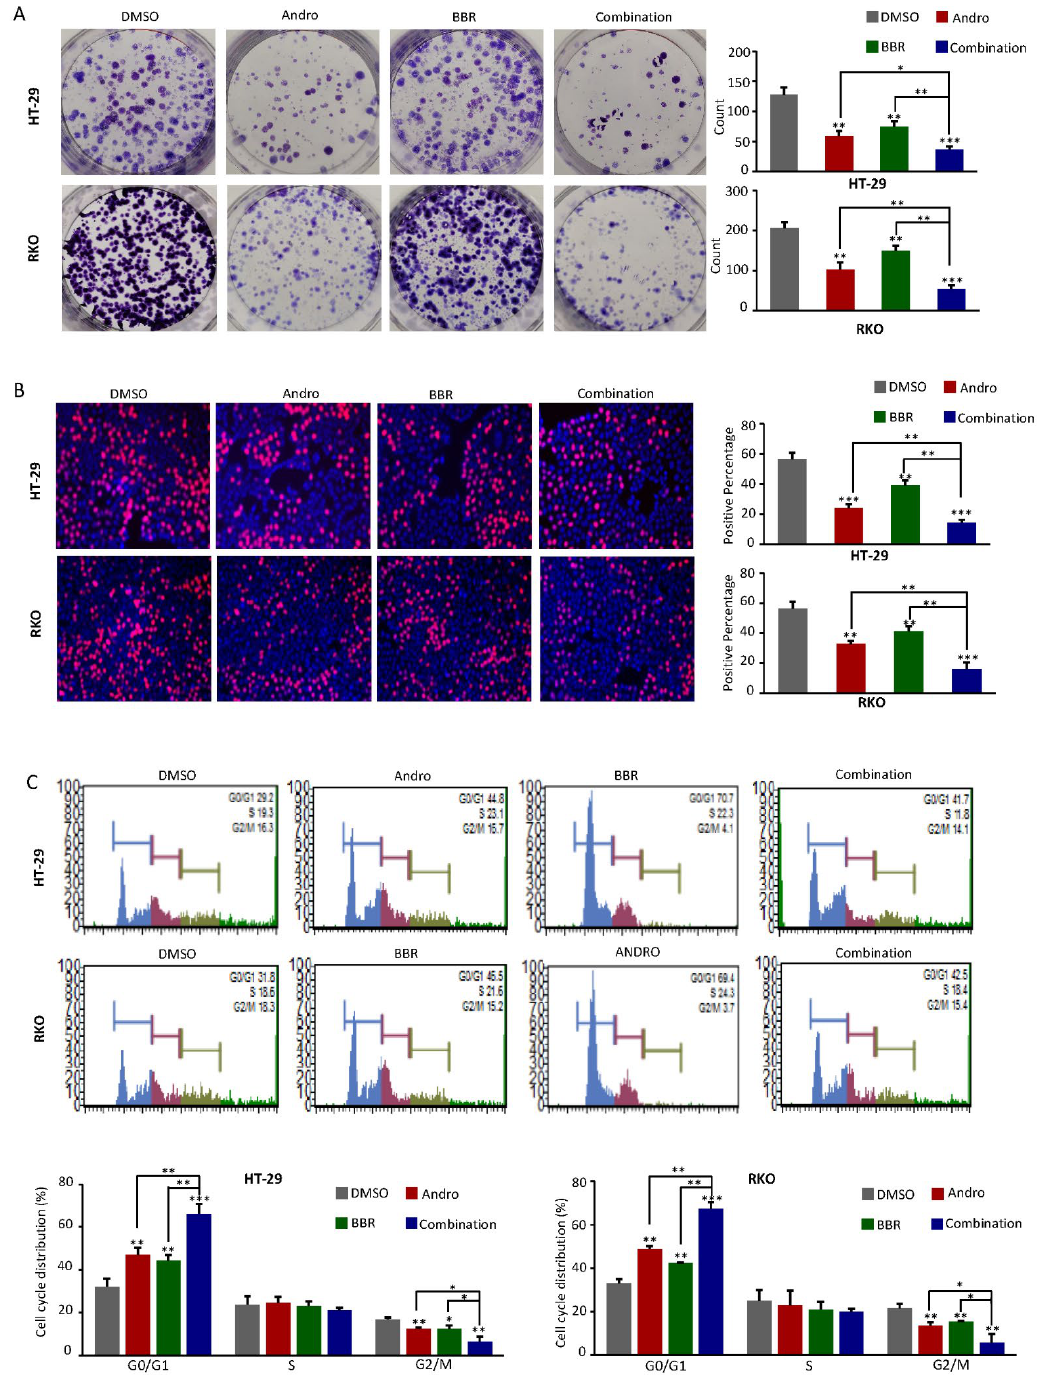
Figure 2. Combined Andrographis- and berberine-induced cell cycle arrest and inhibited cell prolifer- ation. ( A ) Representative results of the colony formation assay in HT-29 and RKO cells after exposure to Andrographis and berberine alone and in combination for 7 days. The colony count analysis is shown in the right panel; ( B ) Representative results of the EdU assay (EdU, red; Hoechst, blue) after exposure to Andrographis and berberine alone and combination for 48 h. The quantitative analysis of the EdU-positive cells is shown in the right panel; ( C ) Representative histograms for the cell cycle distribution in HT-29 and RKO cells after treatment with Andrographis and berberine alone and in combination for 48 h. Values are expressed as the percentage of cells in the G0/G1, S, and G2/M phases of the cell cycle in the lower panel. Statistical Significance: * p < 0.05, ** p < 0.01, *** p < 0.001. BBR, berberine; Andro,